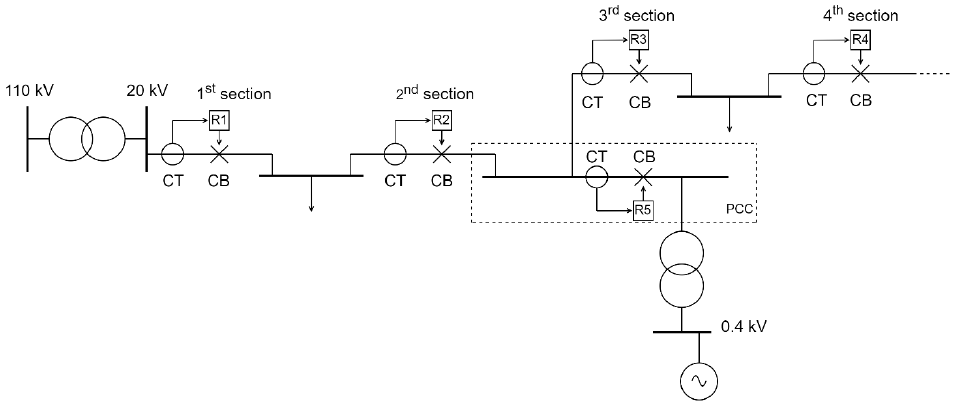
Figure 5. Typical connection of a DG on a MV distribution network feeder.